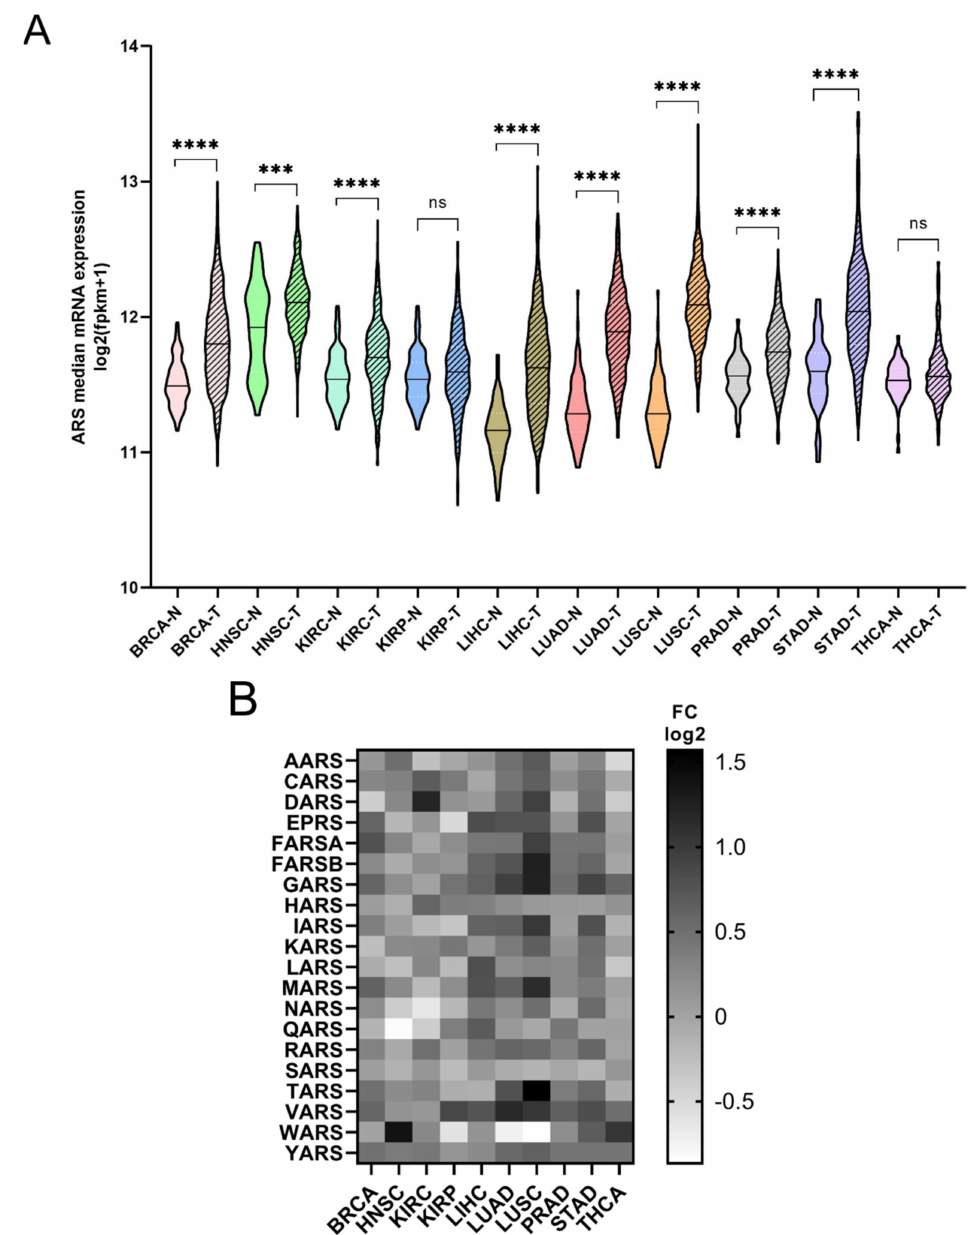
Figure 2. ARS mRNA expression in normal and tumour tissues. ( A ) Median ARS mRNA expression in normal (N) and tumour (T) tissues. The p -values were calculated using the non-parametric Mann– Whitney test. **** p < 0.0001, *** p < 0.001, ns: not significant. ( B ) Fold change (FC) of individual ARS median expression in tumour vs. normal